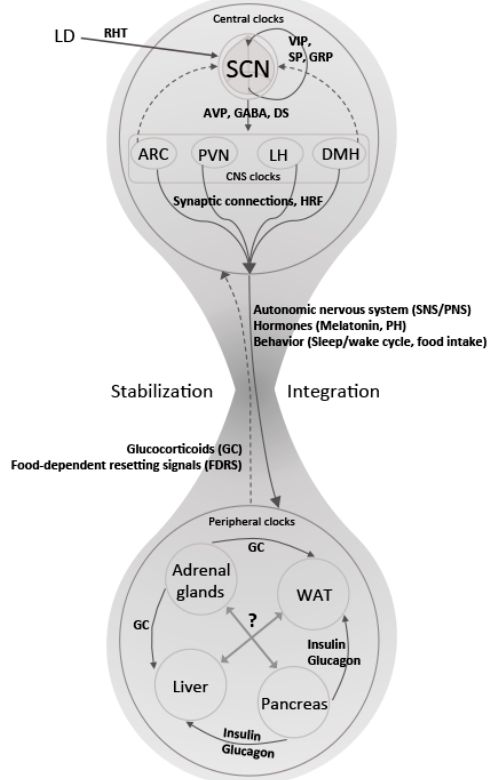
Figure 1. Represents pathways and signals involved in clock-to-clock communication responsible for the integration and stabilization of biological rhythms at central and peripheral levels. The suprachiasmatic nuclei (SCN) receive light information (LD) from the retina as photic input via the retinohypothalamic tract (RHT). The neurons in the SCN are organized as a coupled network of neuronal connections communicating through several neurotransmitters (Vasoactive intestinal peptide (VIP), Substance P (SP), Gastrin releasing peptide (GRP), etc.). The temporal information is then conveyed through Vasopressin (AVP), gamma-aminobutyic acid (GABA) and diffusible signals to other clocks in the brain such as ARC (arcuate nucleus), PVN (paraventricular nucleus), LH (lateral hypothalamus), DMH (dorsomedial hypothalamic nucleus), among others. An integrated response is translated from the brain, through neural projections from the autonomic nervous system and humoral signals, to peripheral tissues (solid arrows). Peripheral clocks receive the time information, communicate with each other and release signals that feed-back (dotted arrows) to the clocks in the brain. The cooperation between central and peripheral clocks results in the stabilization of the rhythms that finally regulate tissue physiology in synchrony with external